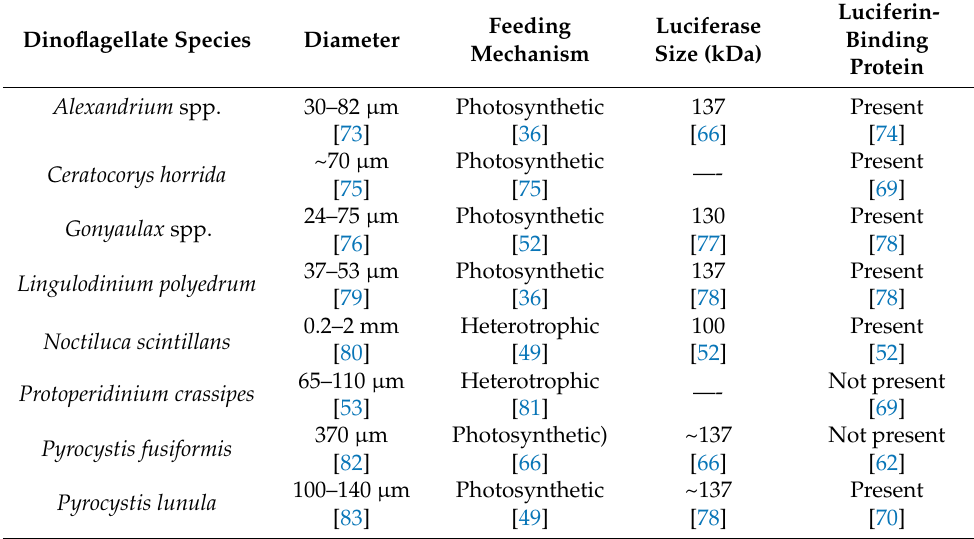
Luciferin- Feeding Luciferase Binding Mechanism Size (kDa) Protein